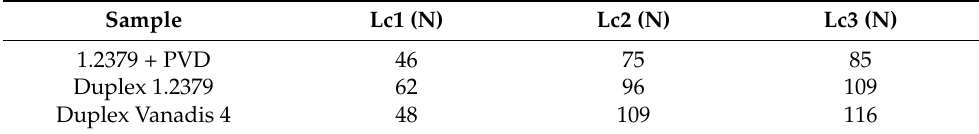
Table 6. Summary of the critical load values obtained for each sample from the scratch test. Sample Lc1 (N) Lc2 (N) Lc3